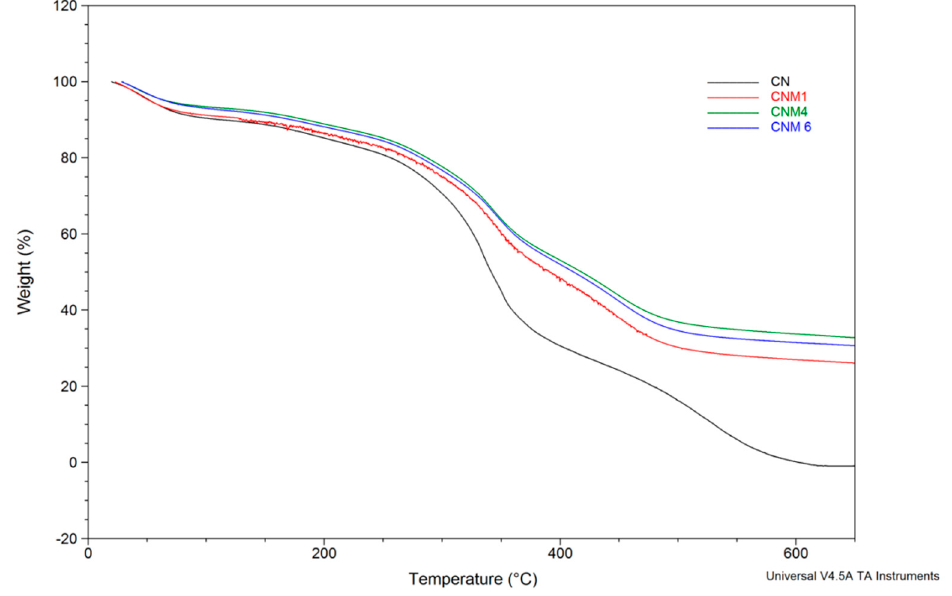
Figure 6. Thermogravimetric curves for CN, CNM-1, CNM-4, and CNM-6.